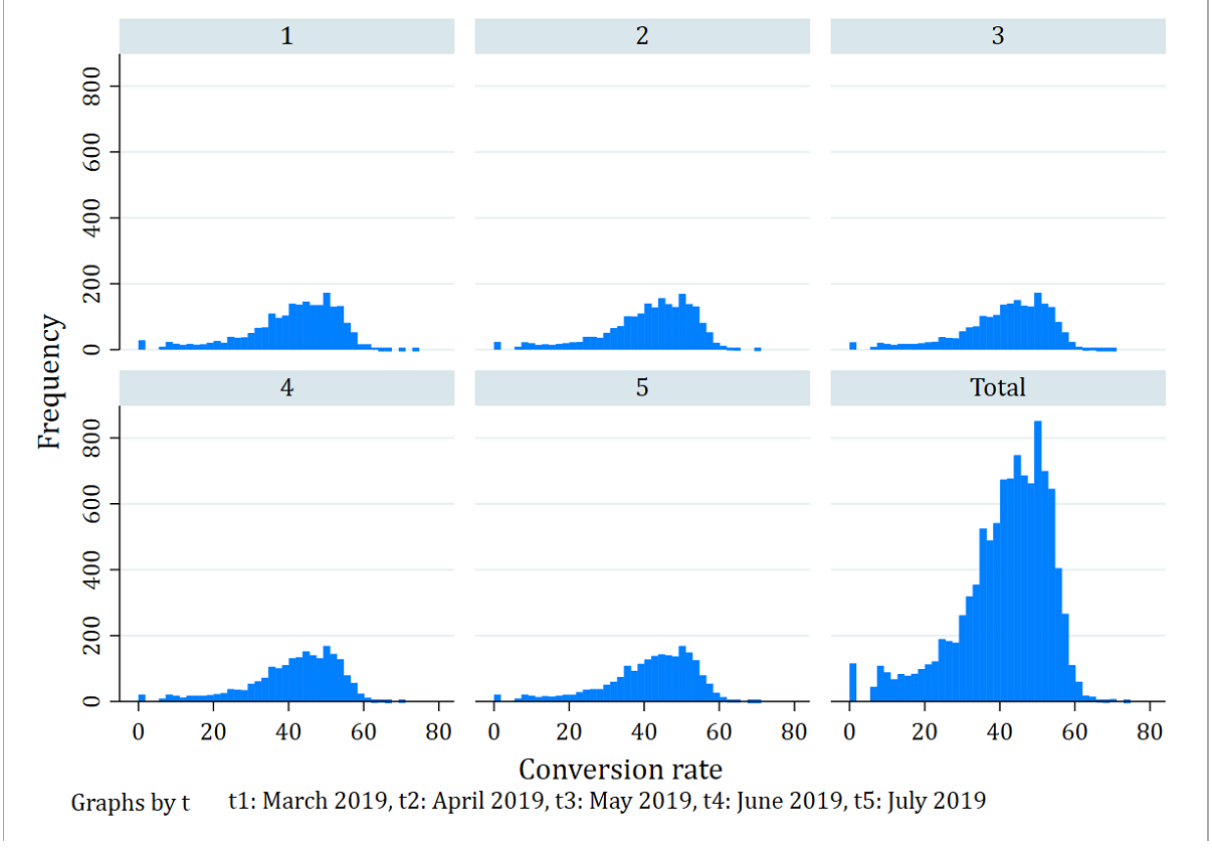
Figure 4. Frequencies of conversion rates in the online health community over five time periods.